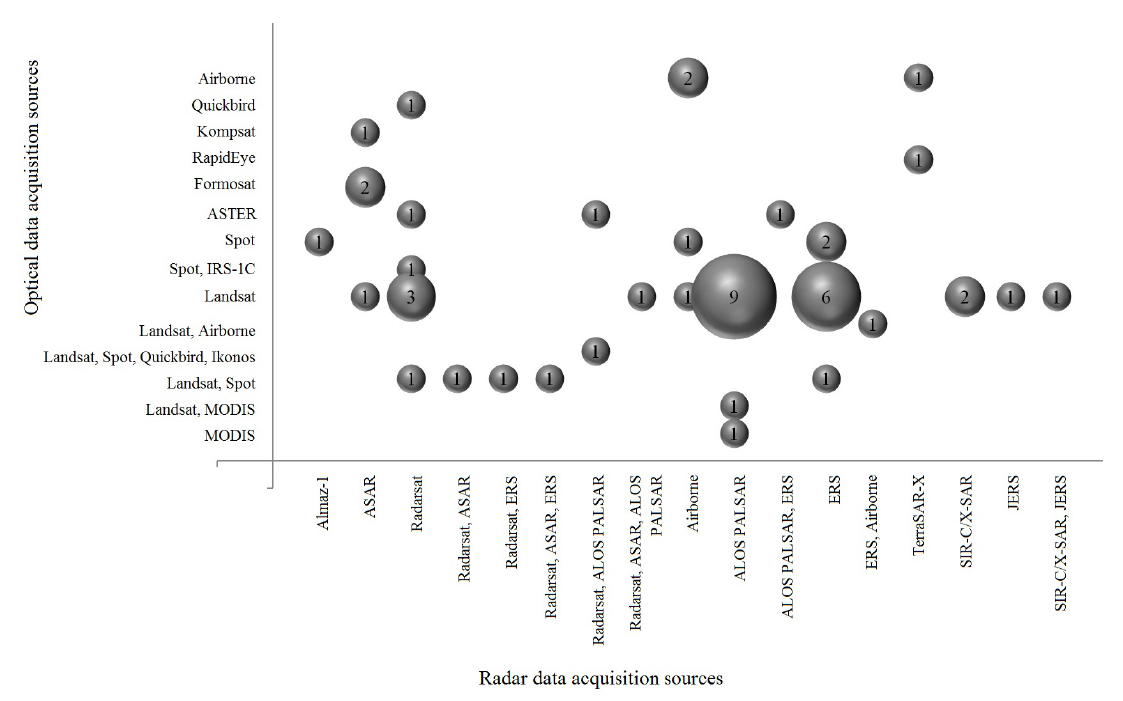
Figure 5. Optical- and radar-based sensors used in land use-related studies selected for analysis. Satellites with the same configuration and sensors (e.g., Landsat 4 and Landsat 5 or ERS-1 and ERS-2) are not distinguished.